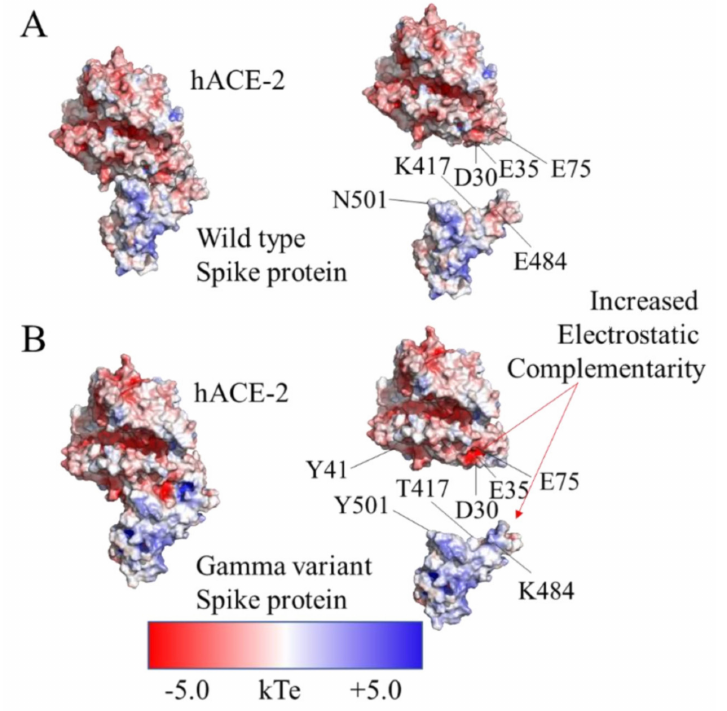
Figure 5. Mutation N501Y induces a cis configuration at 495Y main chain. ( A ) Histograms of ψ dihedral angle of Y495 from the wt (blue) and gamma variant (red) MD simulations. ( B ) 2Fo-Fc electron density maps around Y495 for the wt and VoC crystallographic complexes (PDB codes: 6MOJ, 7EKF, 7EKG, 7EKC, 7WBQ and 7WBP). The electron density, contoured at 1.5 σ (pale green mesh), is shown around residues Y495, G(S)496 and N(Y)501 of the spike protein (black sticks), and residue K353 of the hACE2 receptor (orange sticks).